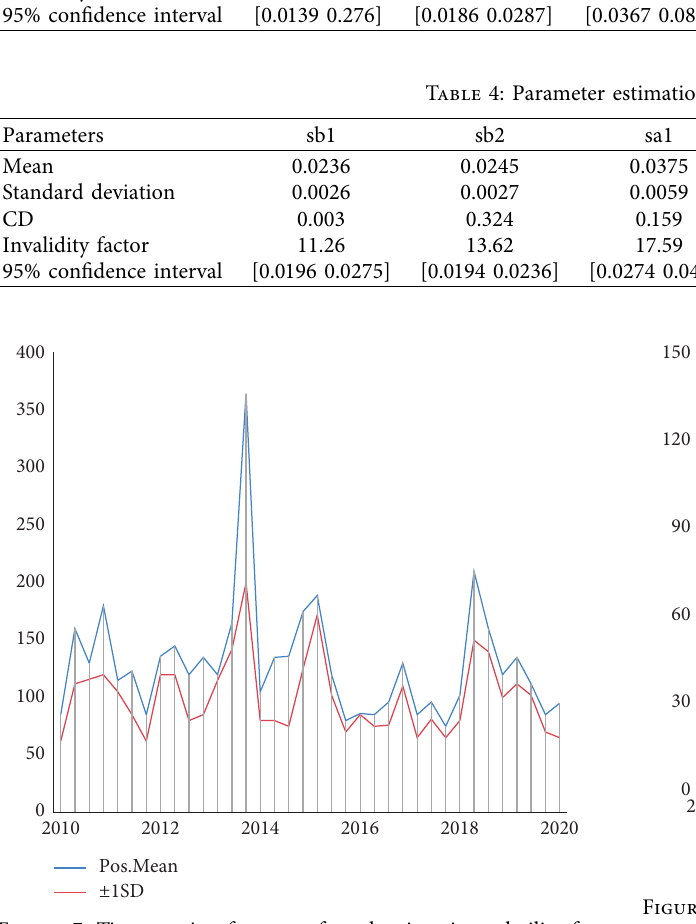
Figure 7: Time-varying features of stochastic price volatility for APM commodities.